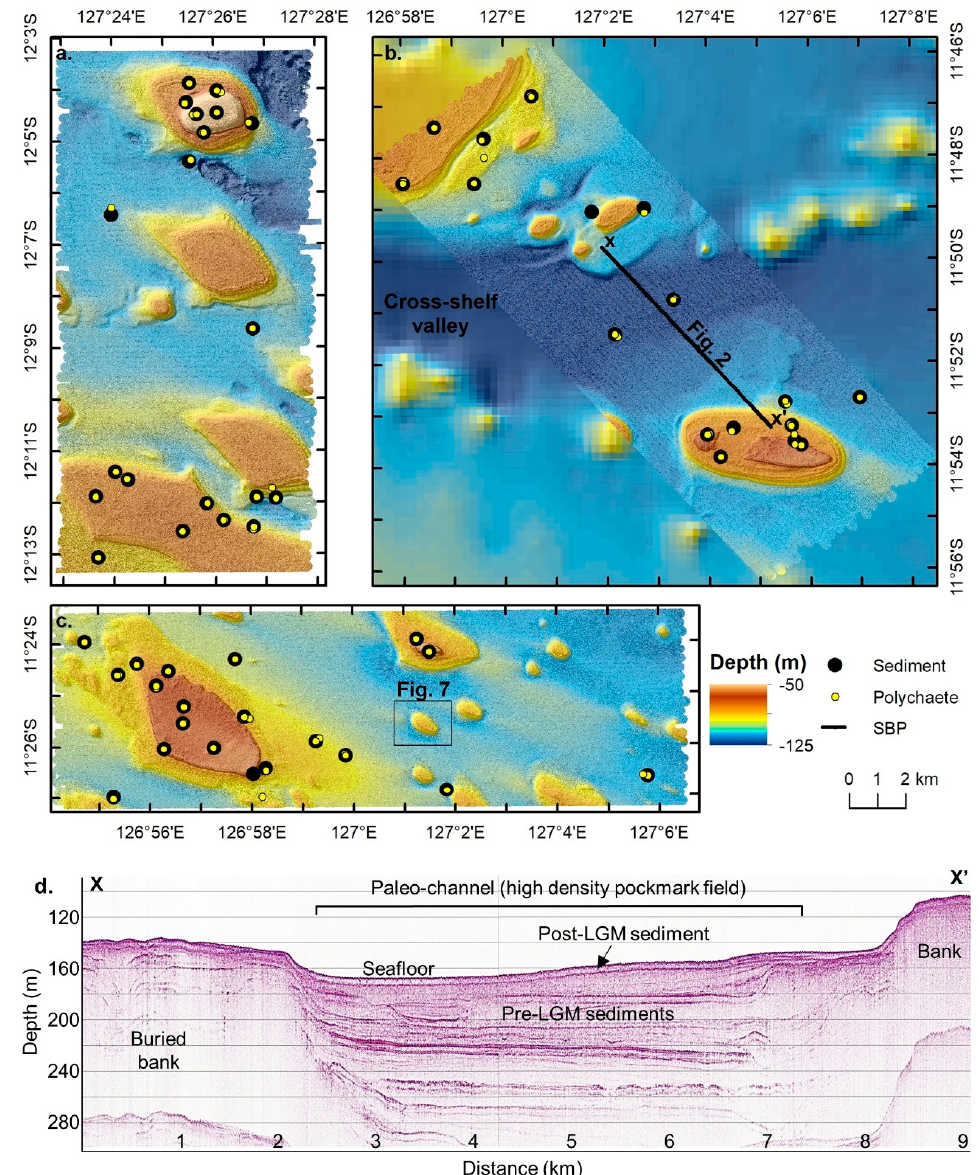
fig 2 Figure 2. Hillshaded bathymetry data of the three survey areas in the Oceanic Shoals Australian Marine Park (AMP) and location of sediment samples used for the various analyses. ( a ) Area 1, ( b ) Area 2 overlaid on the 250 m bathymetry grid [38] and showing the area in relation to the cross-shelf valley existing within the Sahul Syncline, and ( c ) Area 3 also showing the location of Figure 7. ( d ) Sub-bottom profile across Area 2 cross-shelf valley ( b